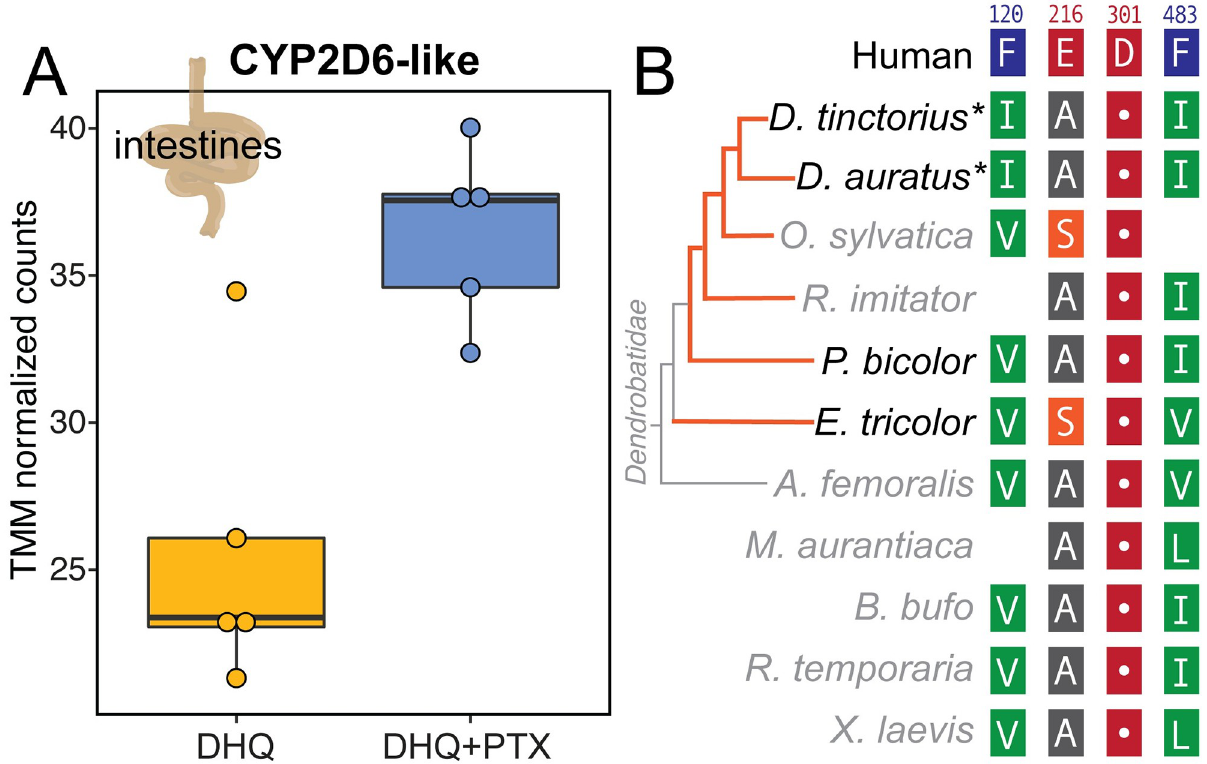
Fig 4. CYP2D6 expression and sequence conservation. (A) A CYP2D6-like protein was identified in the D . tinctorius transcriptome that was upregulated with PTX feeding. (B) Alignment of CYP2D6-like proteins in poison frogs and other amphibians show that important human CYP2D6 binding residue Asp301 is conserved, however other active site residues are changed in frogs. Blank spots indicate residues not present in the alignment of those species due to shorter protein sequences. The orange lines on the dendrobatid phylogeny indicate independent origins of chemical defense. Species in black have been tested for ability to metabolize PTX 251D into aPTX 267A , whereas species names in gray have not been tested. Asterisks ( � ) indicate species that sequester aPTX 267A when fed PTX 251D . Amino acid residues are colored using the RasMol scheme, which corresponds to amino acid